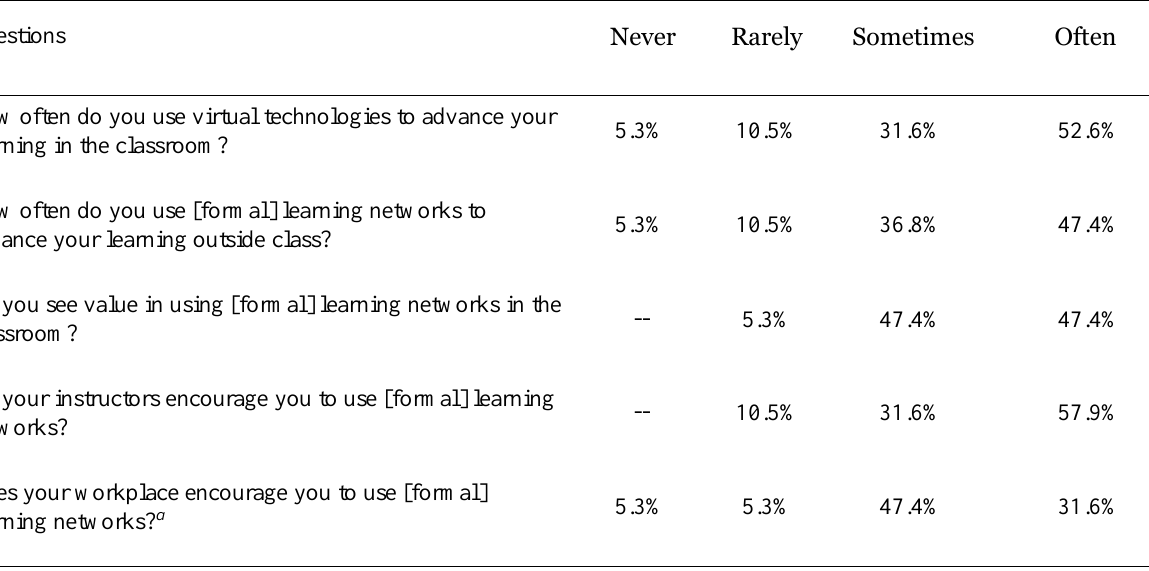
Percentage and Type of Student Formal Network Use